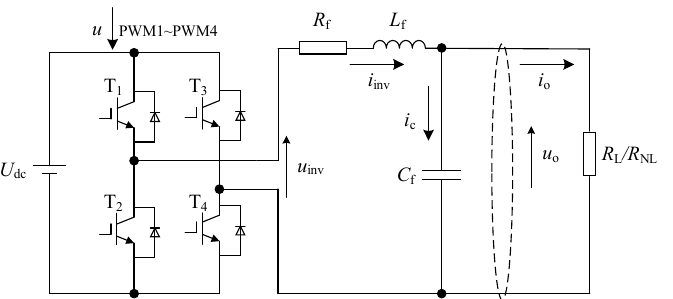
Figure 1. Block diagram of inverter system.